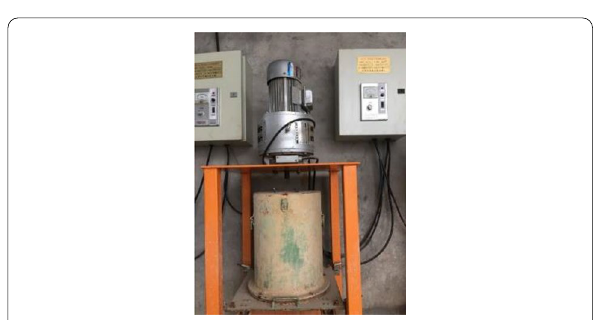
Fig. 4 Ball‑abrasion machine